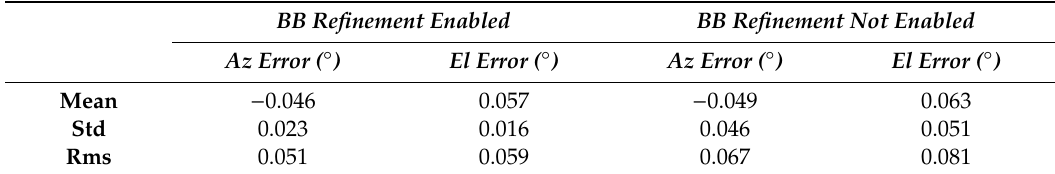
Table 3. Statistical analysis of the accuracy in the estimated target LOS. DL-based detector applied on the images (381) from FT3-A ( τ det =